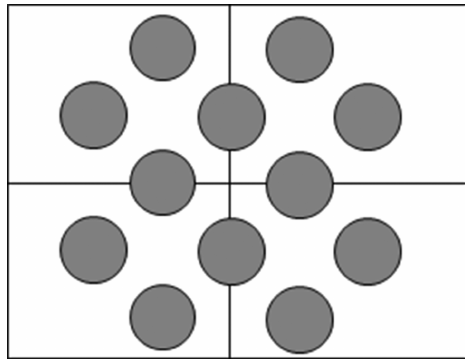
Figure 2. Equidistant paraboloid clouds.